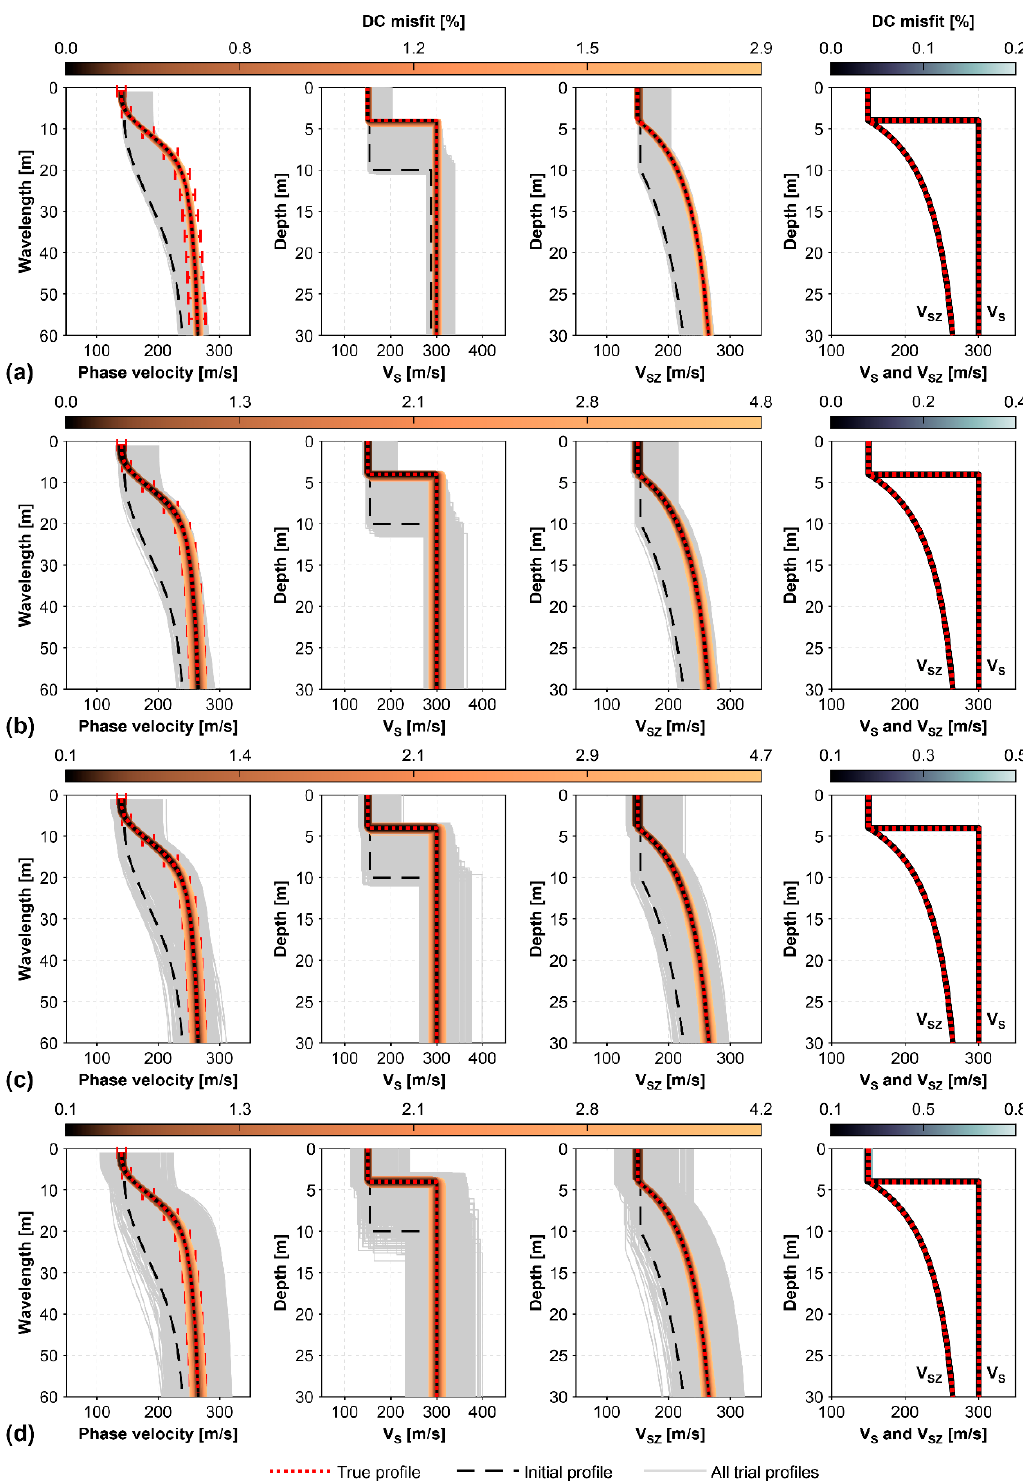
Figure 5. Inversion of the unperturbed synthetic dispersion curve from model A. A two-layer geologic structure was assumed with the layer interface initially positioned at a depth of 10 m. The search-control parameters were specified as ( a ) b = 2.5, ( b ) b = 5, ( c ) b = 10 and ( d ) b = 20. Gray areas display all sampled models. Profiles whose dispersion curves deviate less than 5% from the synthetic curve at all wavelengths are colored based on dispersion misfit values. The lowest DC misfit V S - and V SZ - profiles within each independent set of 1000 iterations are shown in the column furthest to the right.